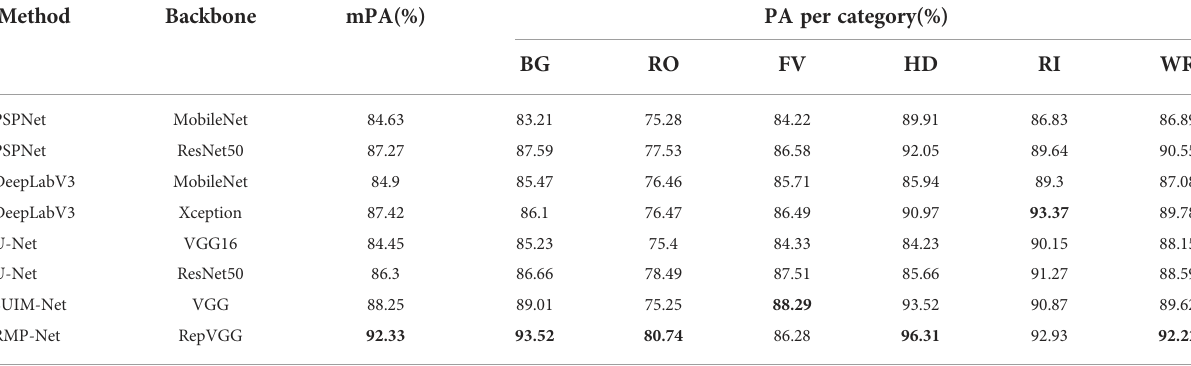
TABLE 6 Comparing mPA metrics between different models on the SUIM dataset, where the metrics with the highest rankings are shown in bold. Method